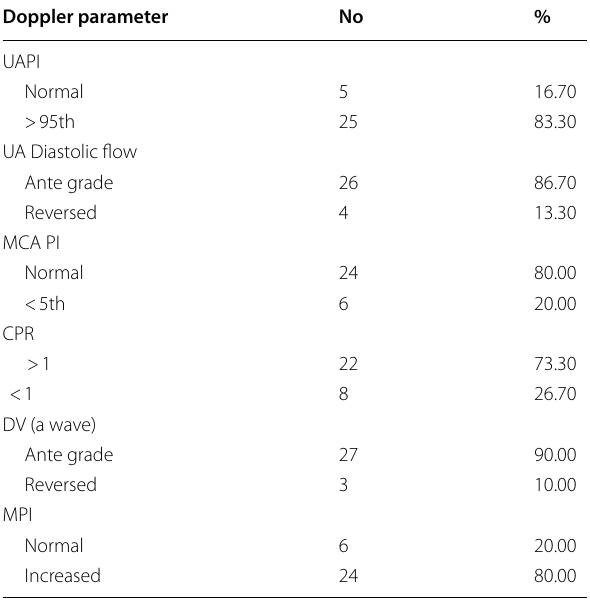
Table 3 Findings of Doppler US of the umbilical, middle cerebral arteries and DV with corresponding MPI in IUGR foetuses